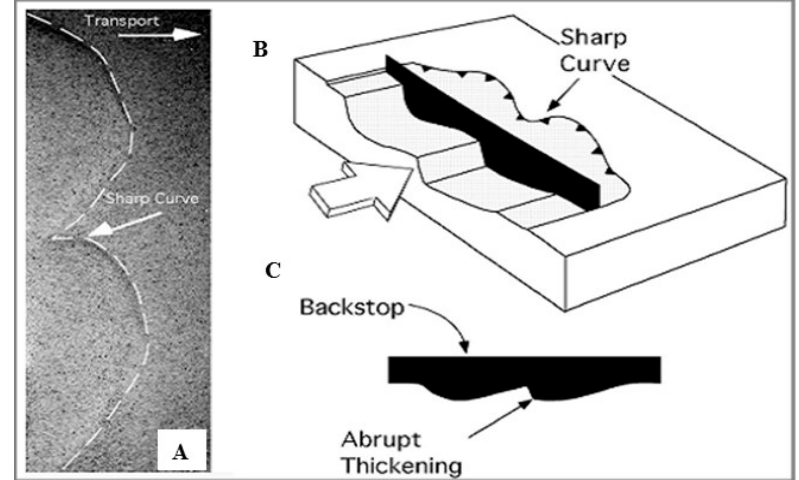
Figure 21. Sandbox model by Paulsen and Marshak [42] assessing the origin of the Uinta recess in the Sevier FTB. The model was set to test the relationship between the thickness of sediments involved in thrusting and the propagation of the FTB to the foreland. ( A ) Sandbox model, viewed from above. ( B ) The backstop was pushed to the right into a layer of sand. ( C ) The top and base of the backstop is variable along the strike, which allows variation in thickness of the sediment involved in thrusting. The experiment shows that whenever the sand wedge is thicker (i.e., more depth to detachment), the thrusts propagate farther to the foreland. A sharp curve occurs at the position of the abrupt change in thickness. Although the experiment is useful to explore the effect of sediment thickness on thrust propagation, it does not explain the reason of this relationship. Also, it does not account for the differential uplift that we see between Salakh E (thicker sediments involved in the deformation) and Salakh W (thinner sediments), which is primarily caused by more incompetent materials filling the core of the anticline.